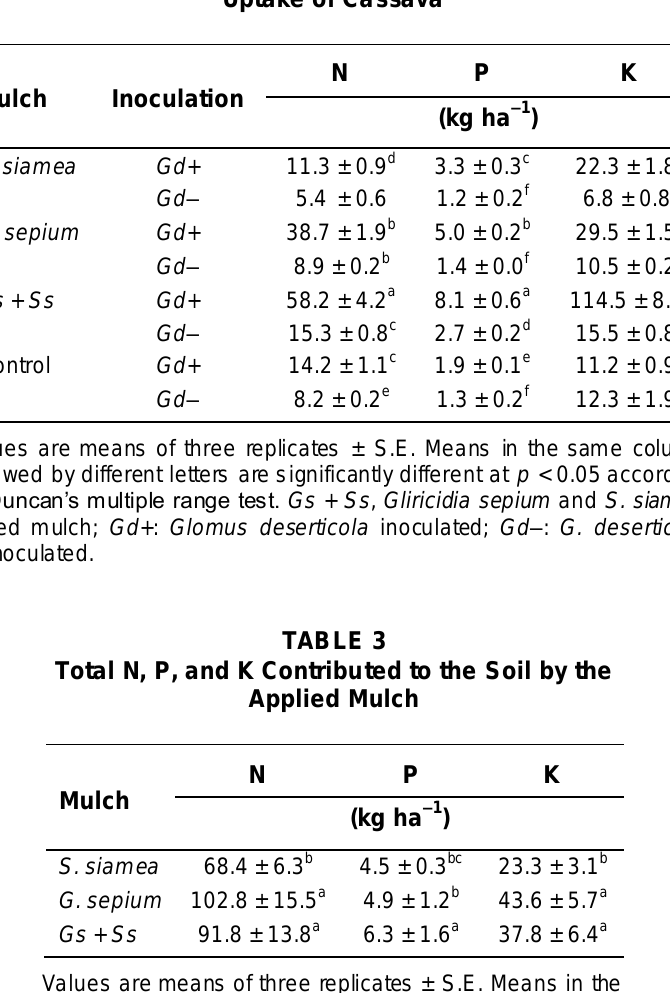
Effect of Glomus deserticola and Mulch on the Tuber Nutrient Uptake of Cassava